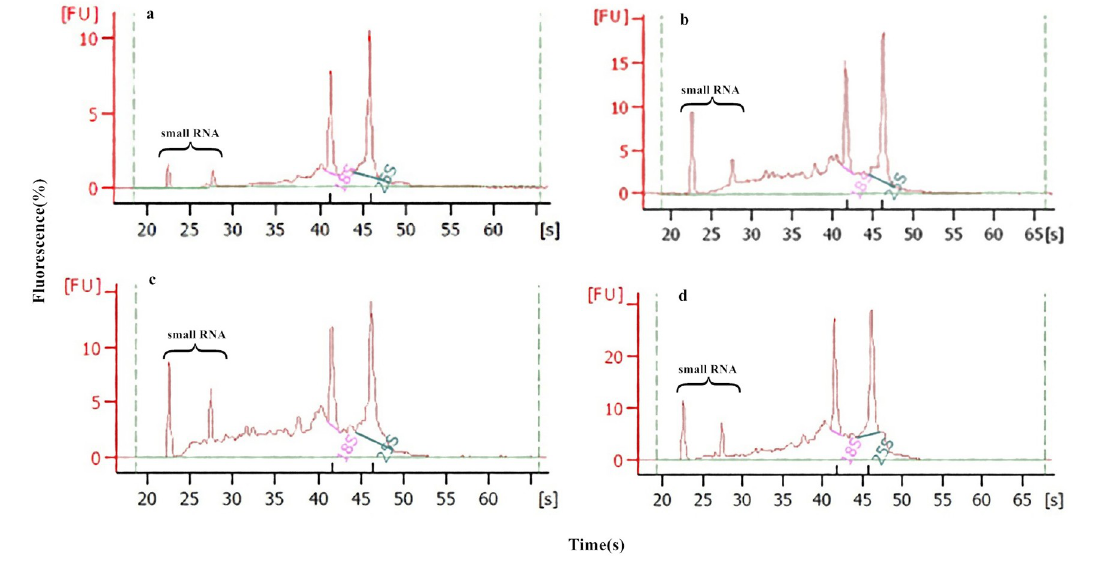
Fig 2. The percentage of maximum RNA fluorescence (FU) during artificial aging for diploid and tetraploid rice seed. (a) Rice seed of 9311-4x, at the beginning of artificial aging. (b) Rice seed of 9311-4x, after 12 days artificial aging. (c) Rice seed of 9311-2x, at the beginning of artificial aging. (d) Rice seed of 9311-4x, after 12 days artificial